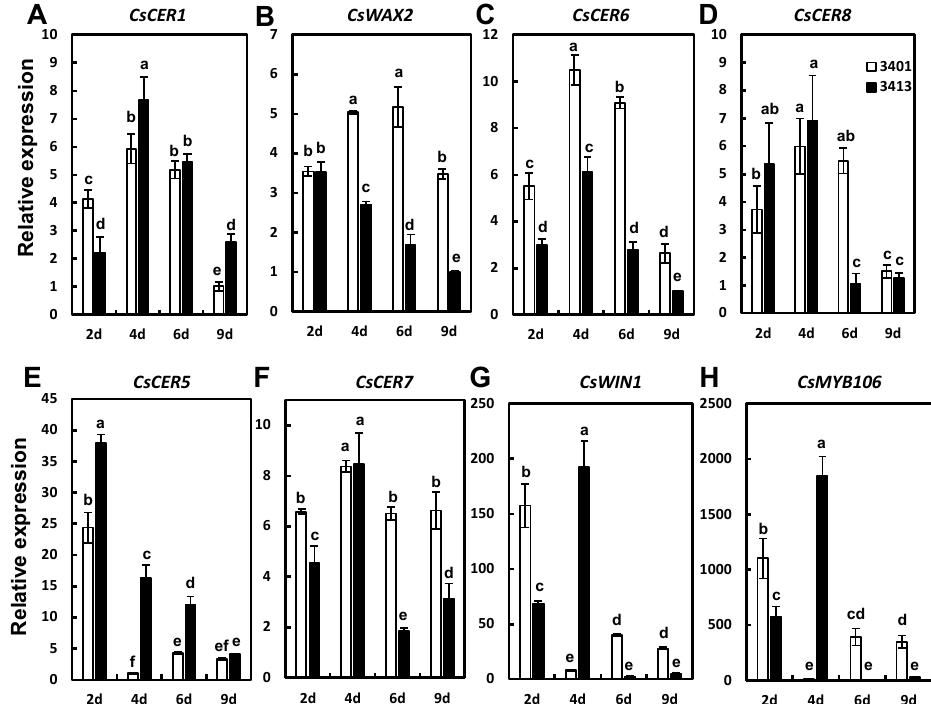
Figure 2. Relative expression of genes related to wax biosynthesis in different fruit developmental stages of 3401 and 3413. ( A – G ) Expression of CsCER1 ( A ), CsWAX2 ( B ), CsCER6 ( C ), CsCER8 ( D ), CsCER5 ( E ), CsCER7 ( F ), CsWIN1 ( G ), and CsMYB106 ( H ) at 2, 4, 6, and 9 DAA in 3401 and 3413. The data of columns are the mean ± standard deviation. The different lowercase letters indicate significant differences ( p < 0.05) by one-way ANOVA analysis with the Dunnett test.